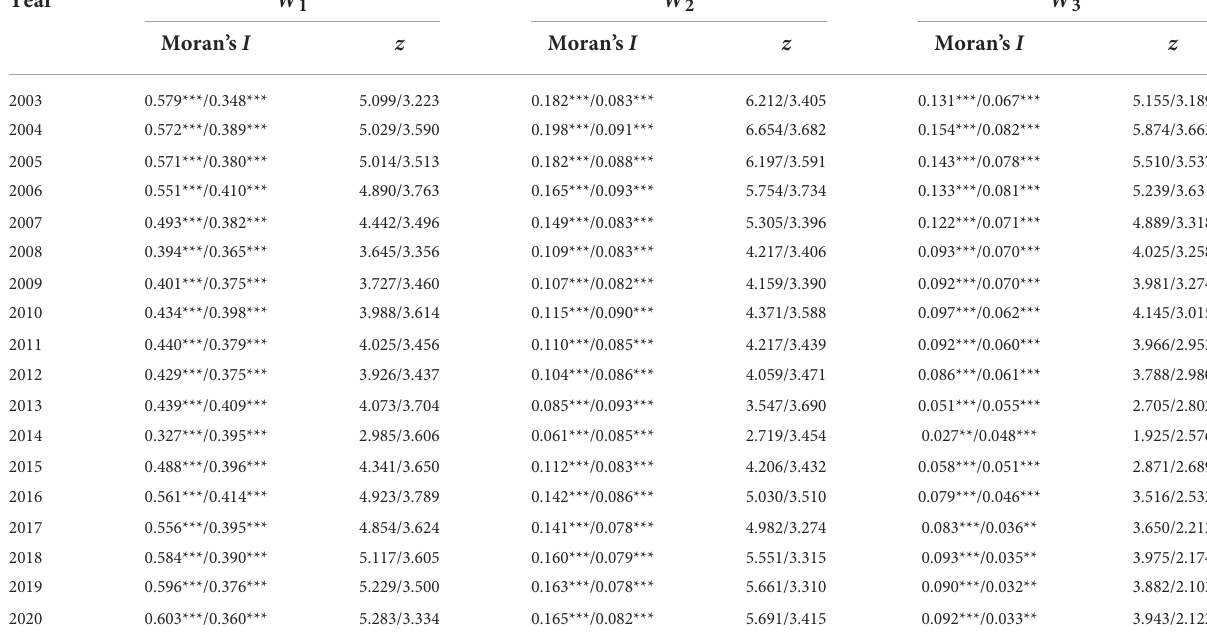
TABLE 4 The results of spatial correlation